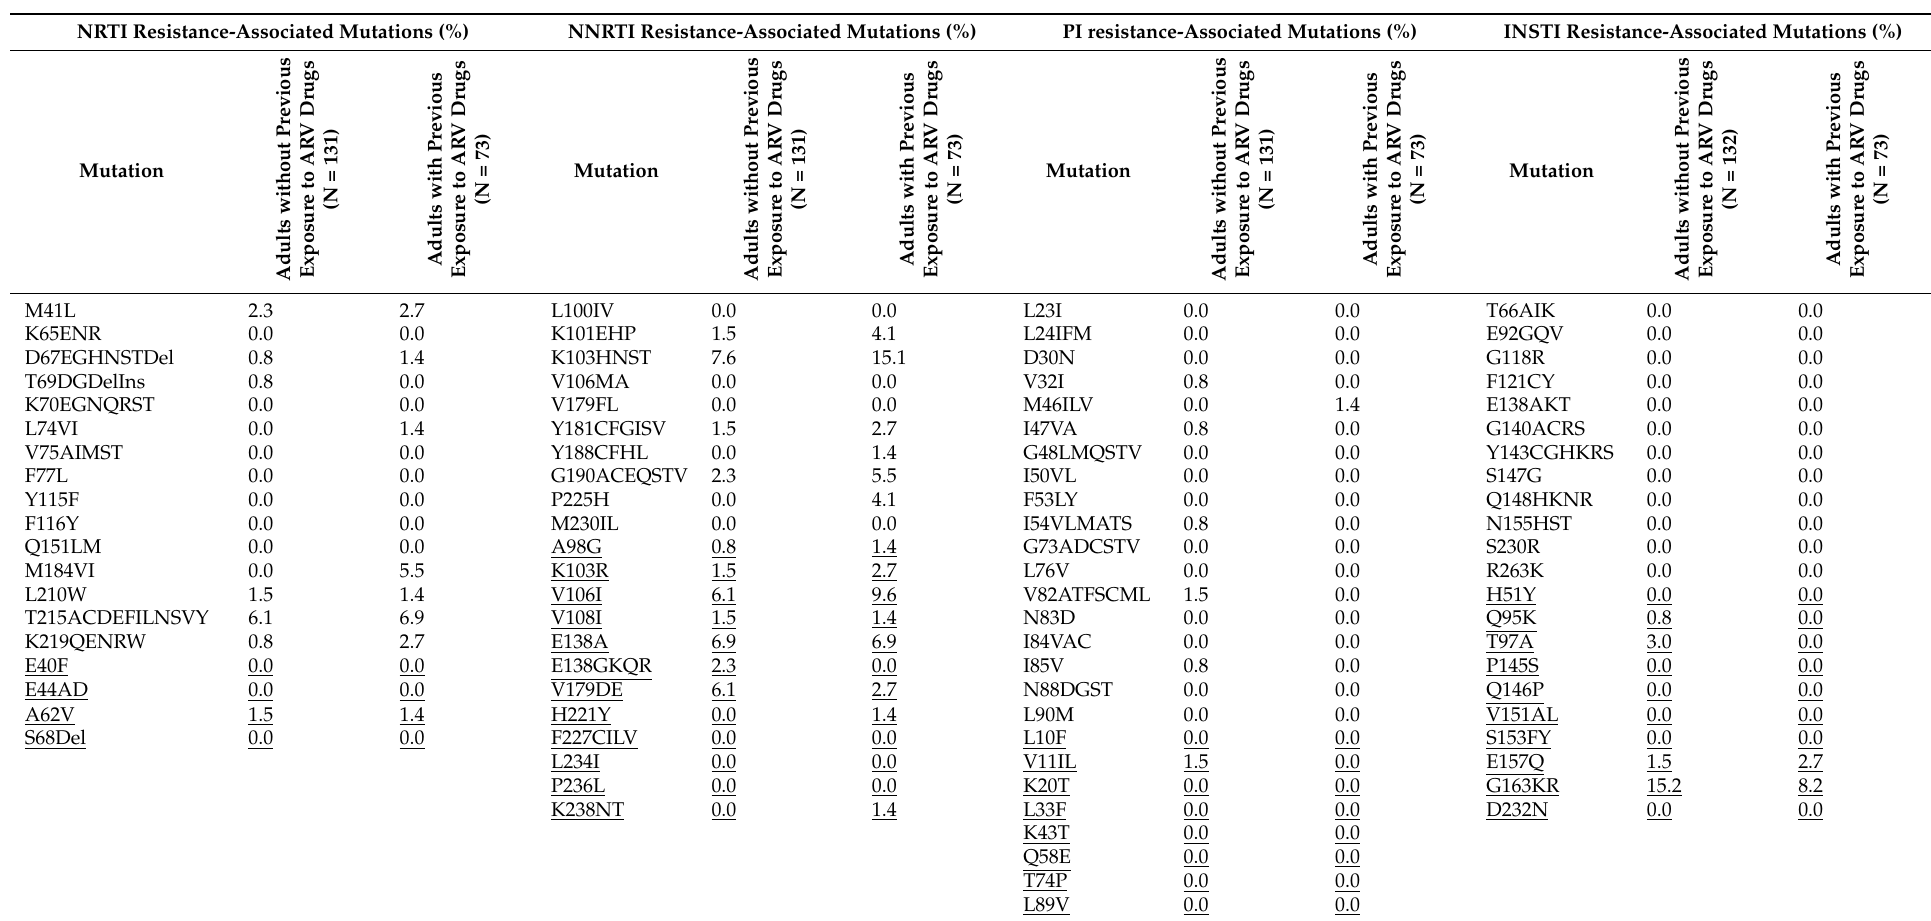
Table 4. Prevalence of HIV drug resistance-associated mutations among adults initiating and reinitiating antiretroviral therapy with and without previous exposure to ARV drugs in Uruguay,